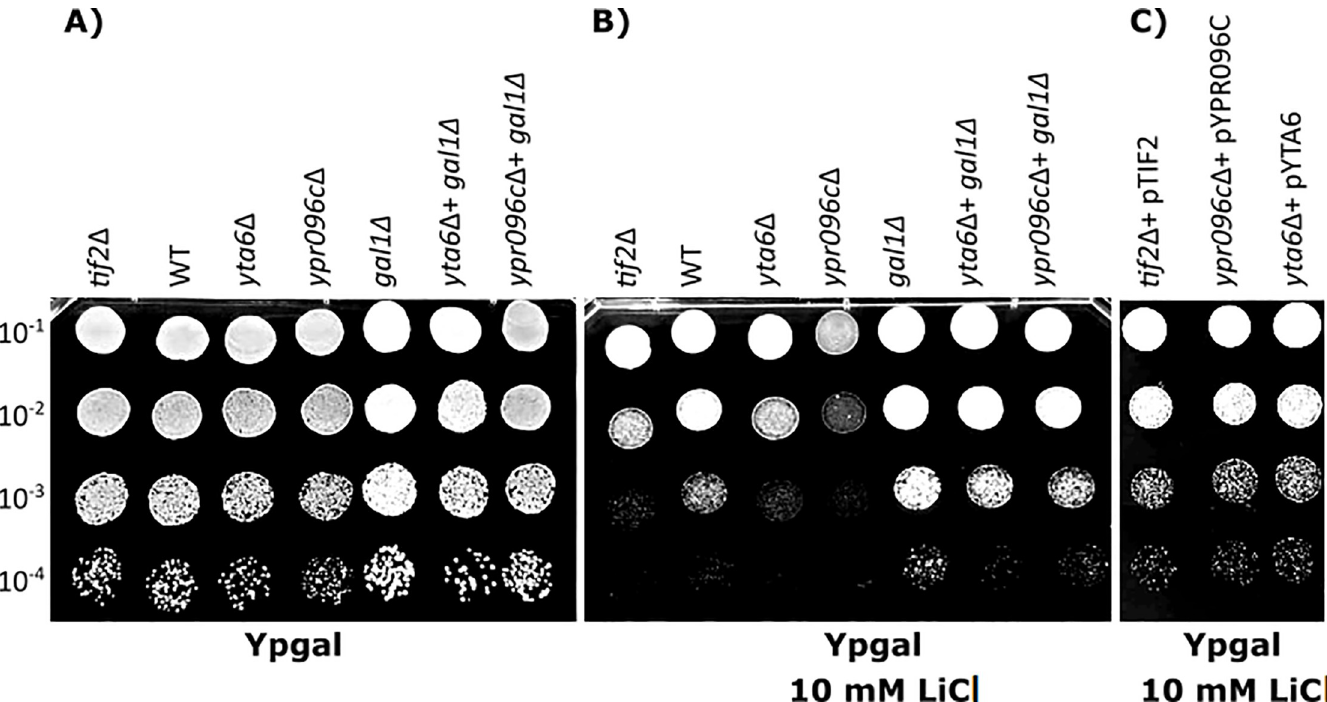
Fig 1. Drug sensitivity analysis for different yeast strains using spot test assay. In (A) and (B) yeast cells were serially diluted as indicated (10 − 1 to 10 − 4 ) and spotted on YPgal media with or without LiCl (10 mM). yta6 and ypr096c show less growth under LiCl treatment. Double deletion for GAL1 with YTA6 or YPR096C suppressed the observed sensitivity of single-gene deletions for YTA6 or YPR096C . Deletion of TIF2 was used as a positive control. In (C) over-expression of the target gene in their corresponding deletion mutants reverted cell sensitivity to LiCl (10 mM). Each experiment was repeated at least three times (n � 3) with similar outcomes.